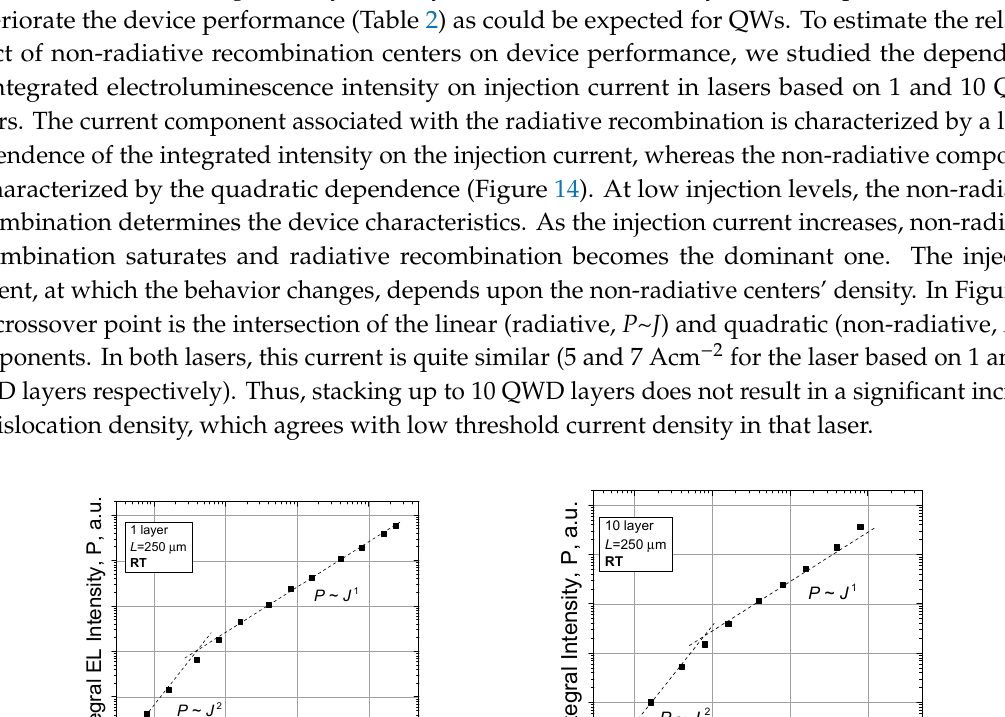
Figure 13. Temperature dependence of the threshold current of QWD-based laser.